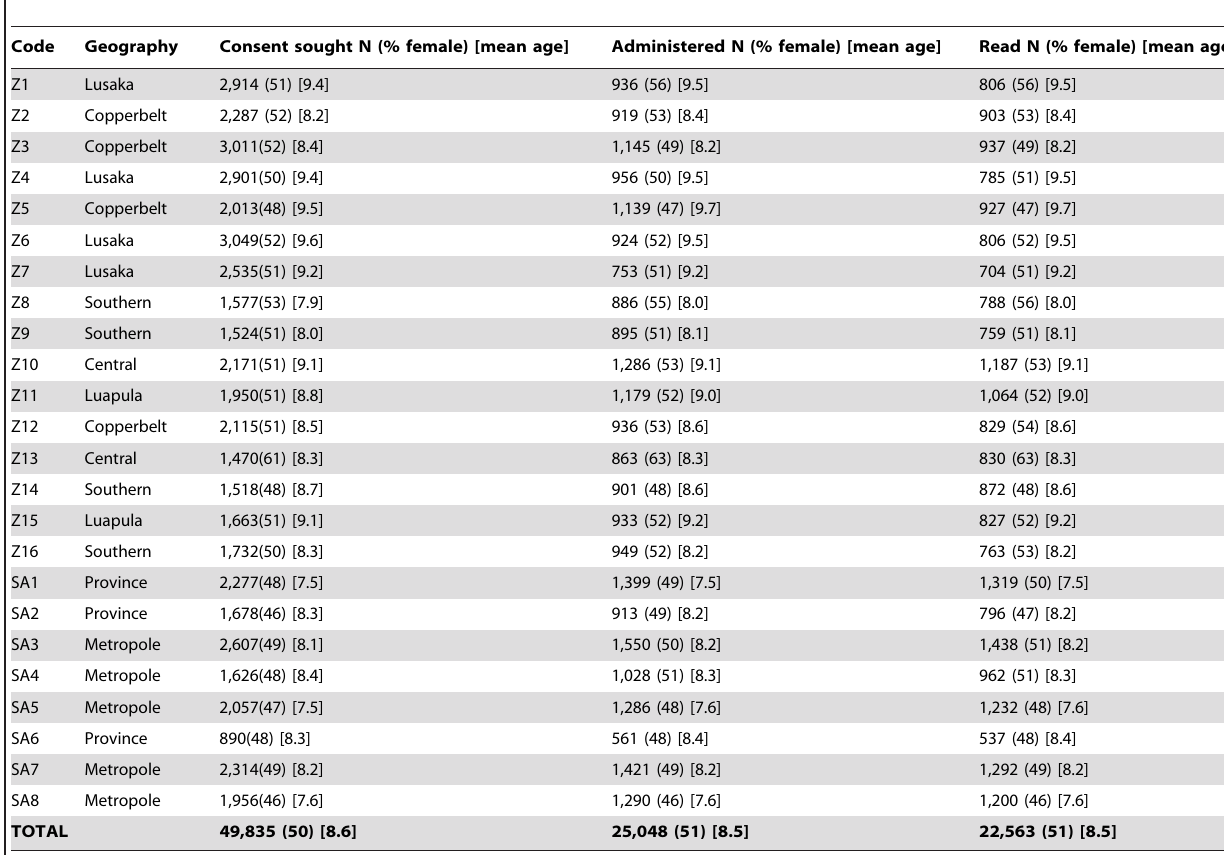
Table 1. Children involved in the baseline tuberculin skin test surveys for all 24 ZAMSTAR communities.